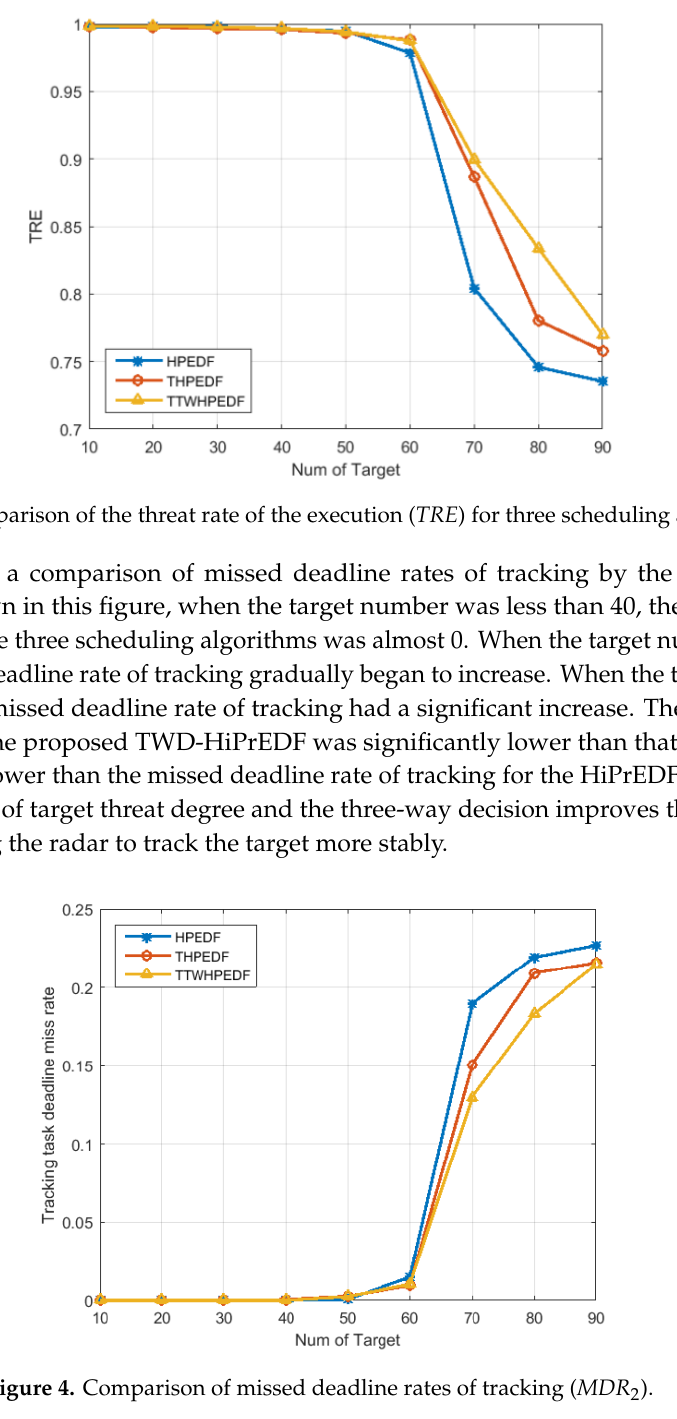
Figure 3. Comparison of the threat rate of the execution ( TRE ) for three scheduling algorithms.